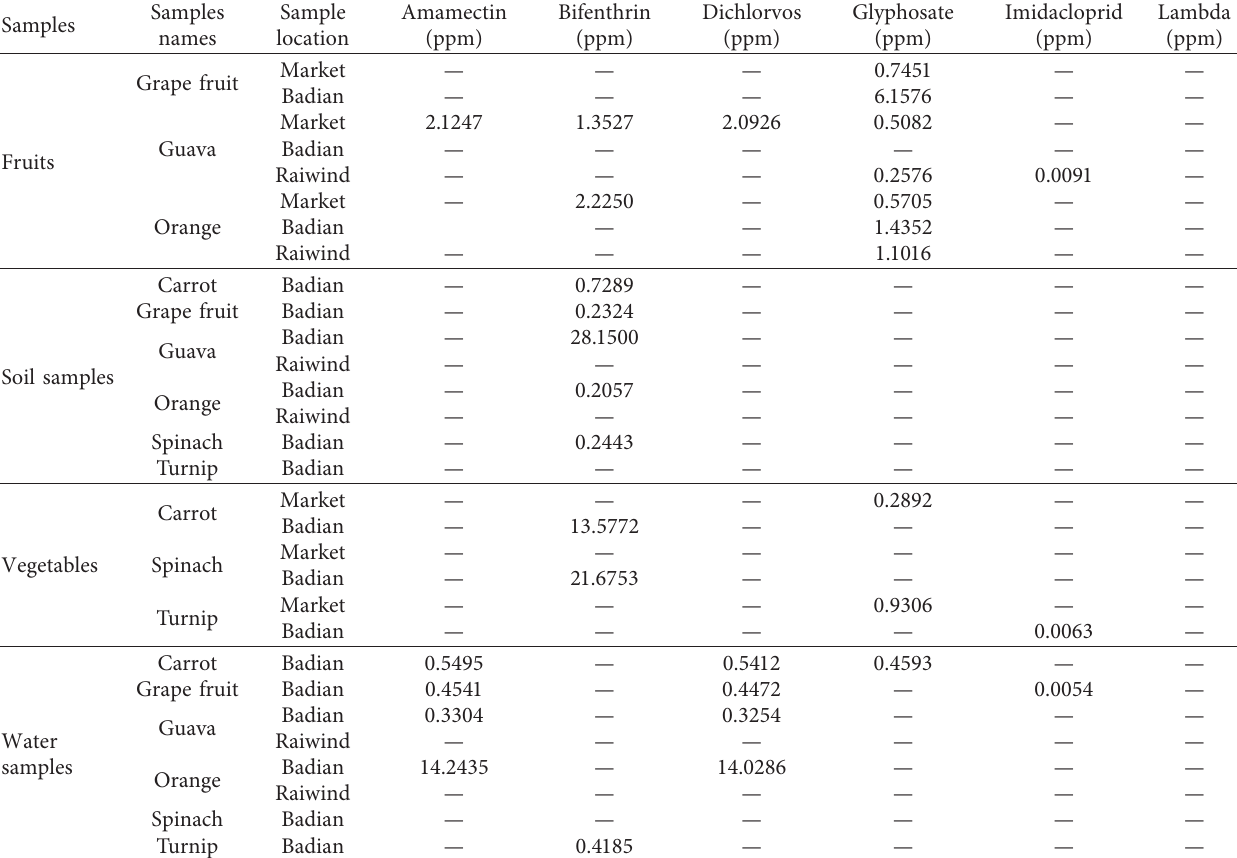
Table 1: Mean concentration of detected pesticides.